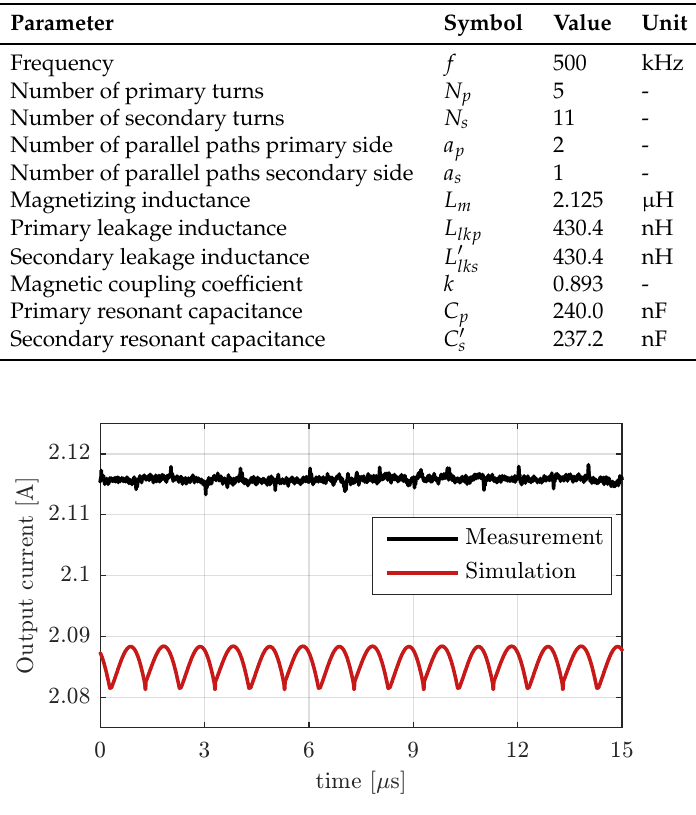
Table 2. Optimal P18/11 pot core resonant transformer design.